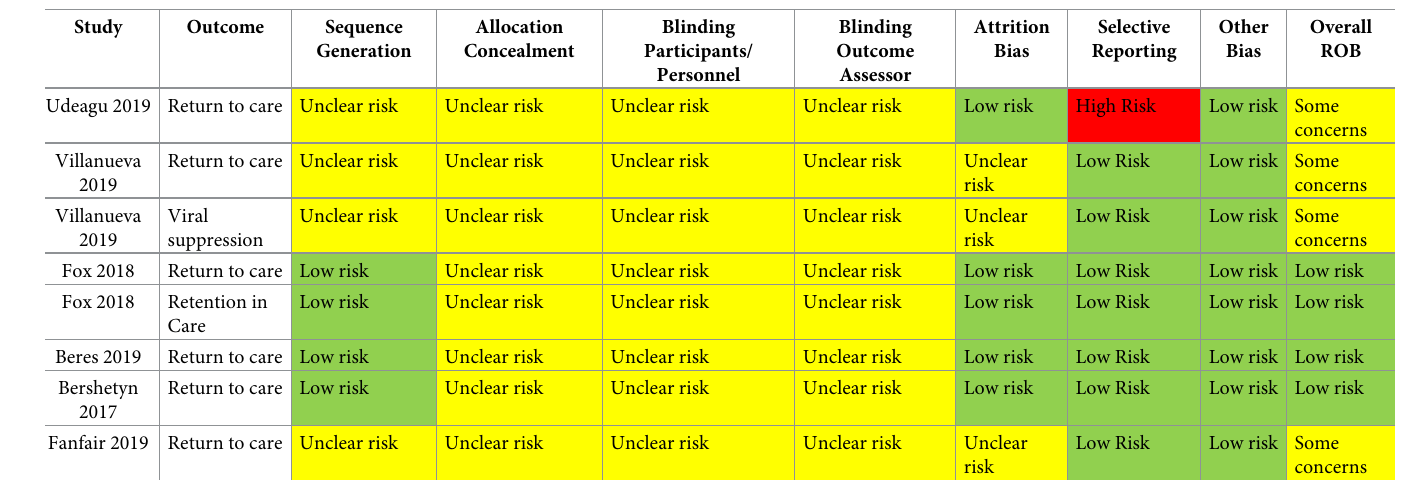
Table 3. Risk of biases in the included RCTs.